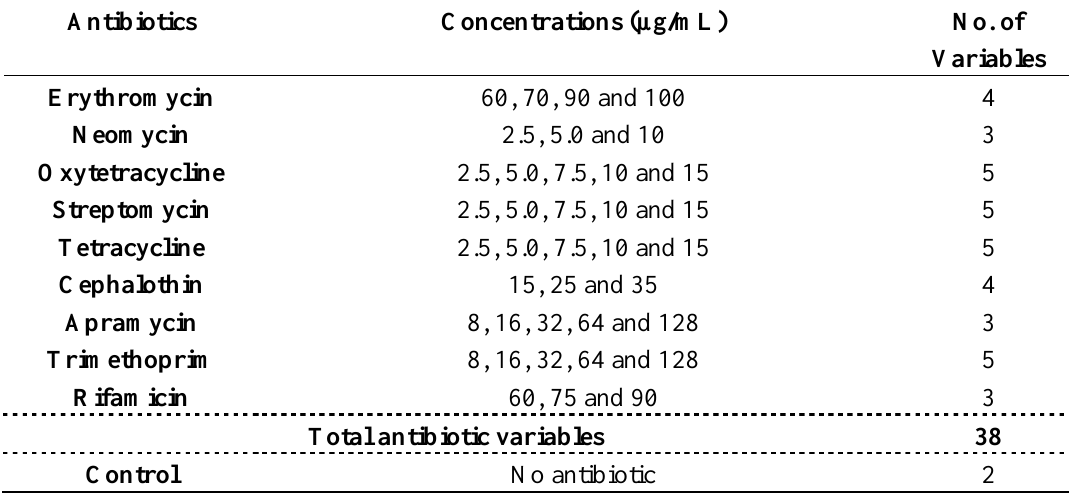
Table 1. Antibiotic concentrations used for antibiotic resistance analysis (ARA) of E. coli